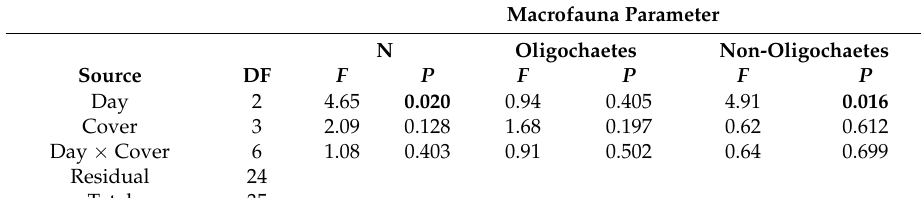
Table 7. ANOVA results for macrofauna in traps: bulk dispersal rates (BDRs). Transformation indicated where applied. Significant differences ( P < 0.05) are in bold and SNK results are presented. D1 = Day 1, D2 = Day 2, D3 = Day 3.